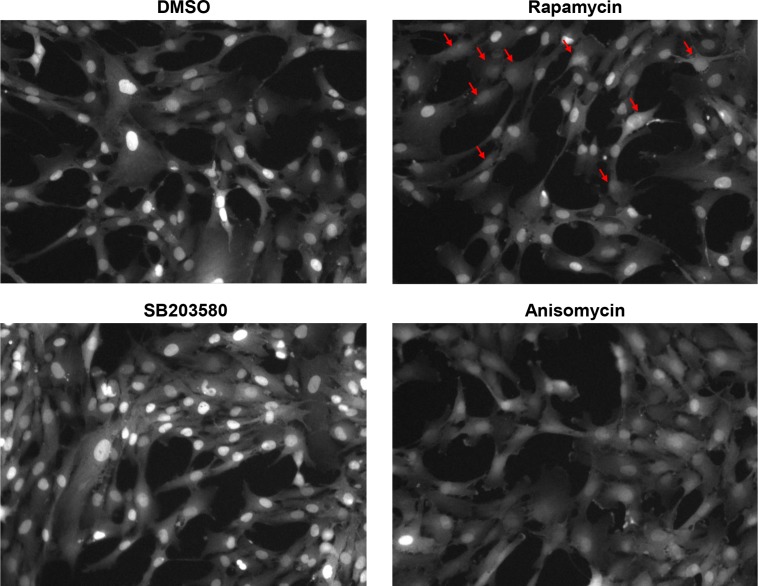
Representative images showing response of the p38 KTR to indicated treatments.The p38 KTR functions by translocating to the cytoplasm once p38 is activated. Cells were imaged after a 1 day treatment with DMSO (control), 3 nM rapamycin or 5 μM SB203580 (p38 inhibitor), or a 30 min treatment with 25 ng/mL Anisomycin (a stimulator of the p38 pathway). Anisomycin treatment results in reduced fluorescence in the nucleus, and a less defined nuclear boundary as compared to control. By contrast, treatment with SB203580 results in elevated fluorescence in the nucleus, implying a lower p38 activity. Cells subject to rapamycin treatment are smaller in size as compared to control. While these cells display a spectrum of cytoplasmic-to-nuclear localization, rapamycin treatment increases the fraction of cells that display p38 activity, as indicated by the blurry nuclear boundary and increased cytoplasmic localization of the KTR (highlighted by arrows).